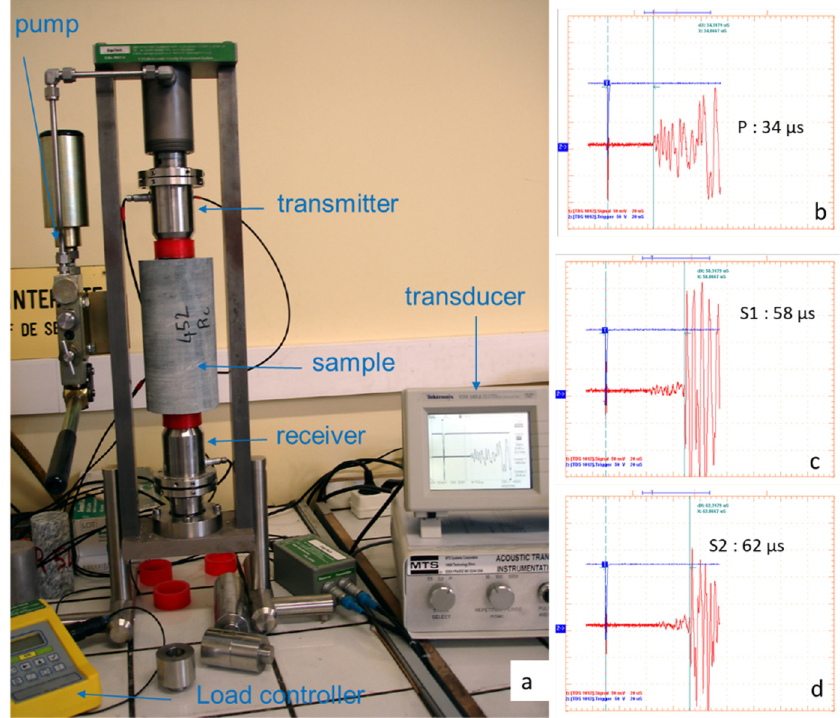
Figure 2. Experimental device ( a ) and representative waveforms of the receive signal: ( b ) P-wave, ( c ) S1-wave and d S2-wave. On ( b – d ): in blue the electric pulse and in red, the received